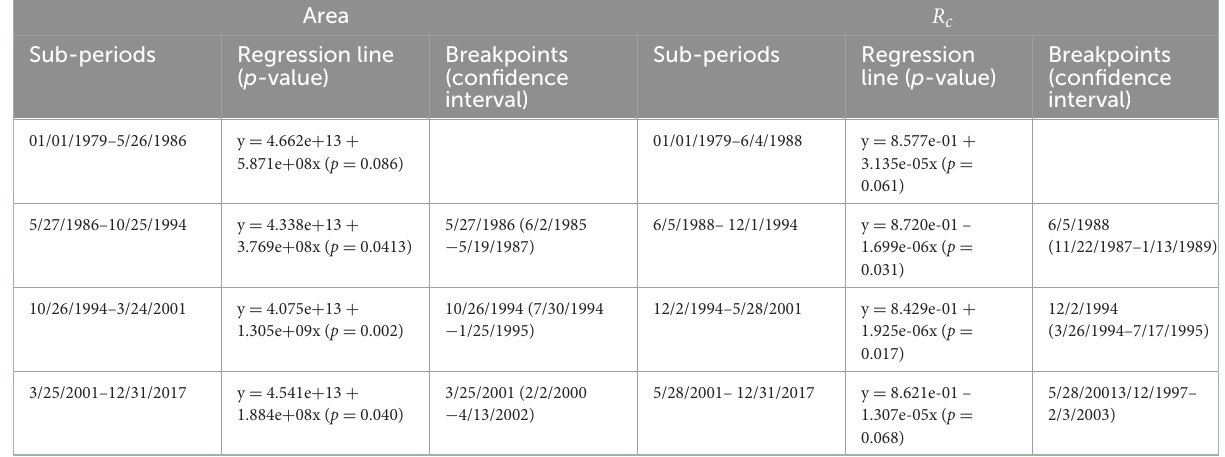
TABLE 1 Regression line with significance of slope, and 95% confidence interval of breakpoints, for NHCPV area and R c